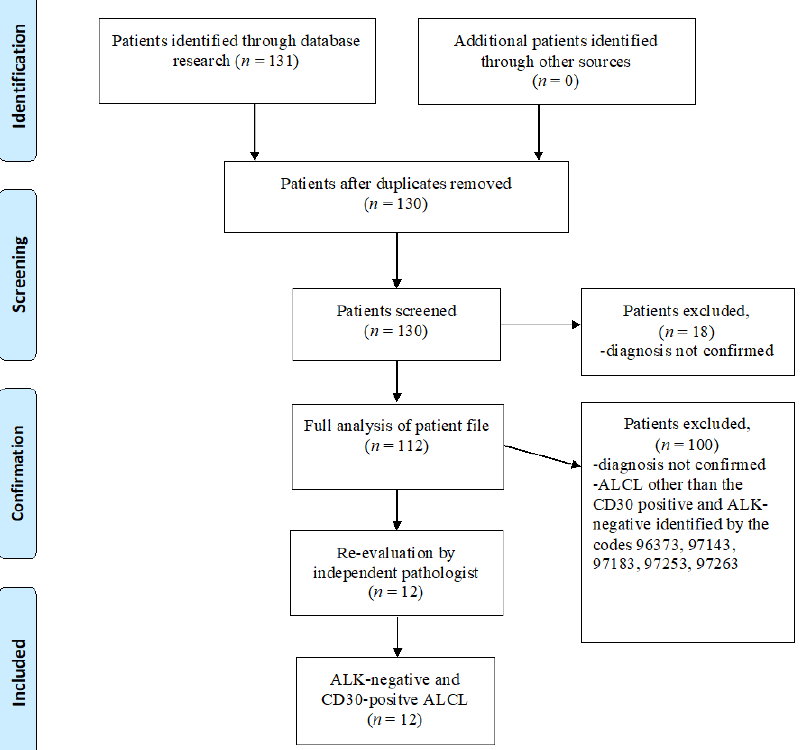
Figure 1. Flow diagram through patient identification, screening, confirmation and inclusion in accordance with the EQUATOR reporting guidelines.